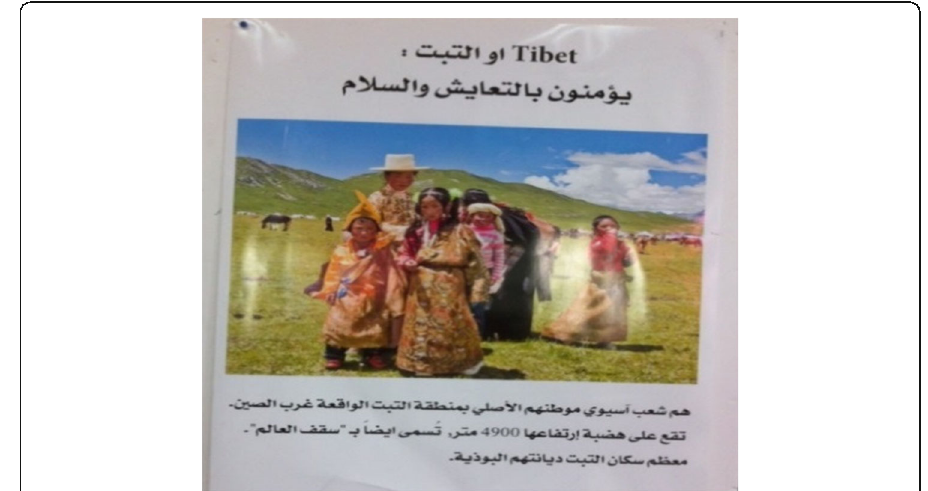
Fig. 11 A symbolic sign- developing intercultural